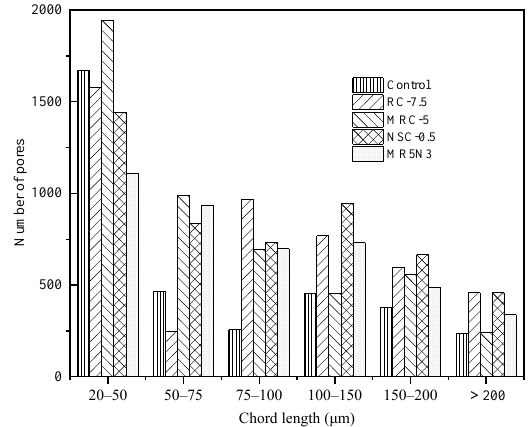
Materials 2021 , 14 , x FOR PEER REVIEW Figure 5. Number vs. chord length. Figure 5. Number vs. chord length.